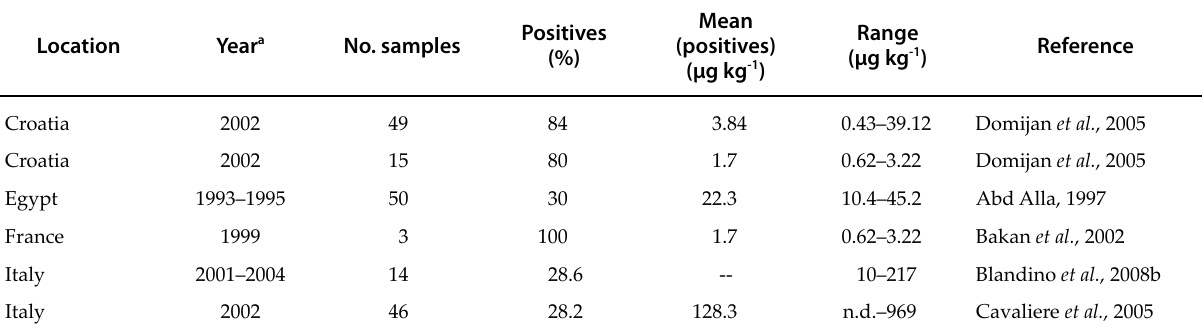
Table 3. Occurrence of zearalenone in freshly harvested maize from Mediterranean countries. Location